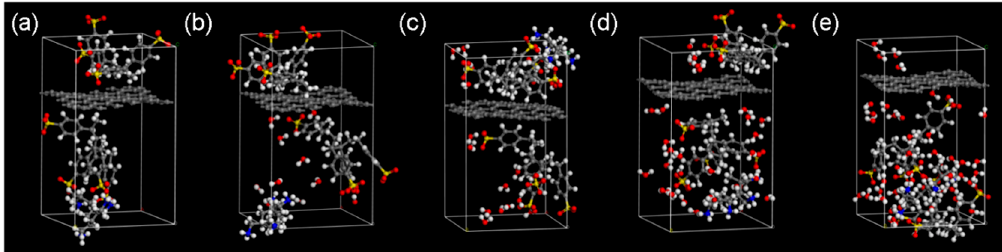
Figure 8. Relaxed atomic structures of the graphene/PSS/PAH composites with water mass fractions of ( a ) 0%, ( b ) 5%, ( c ) 10%, ( d ) 15%, and ( e ) 20%. The oxygen (red), sulfur (yellow), hydrogen (white), nitrogen (blue), and carbon (gray) atoms were distinctively colored.